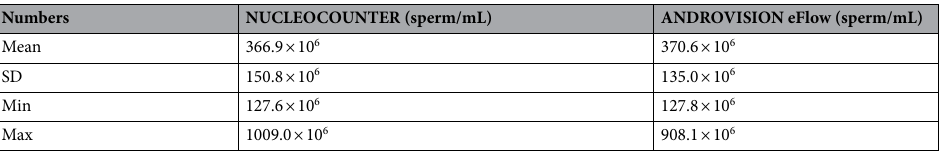
Table 1. Results (mean, SD, minimum and maximum) of sperm concentration measurement with two methods (NUCLEOCOUNTER, ANDROVISION eFlow) from 185 raw boar ejaculates. The mean values for sperm concentration did not differ significantly (paired Student’s t-test; P = 0.25).